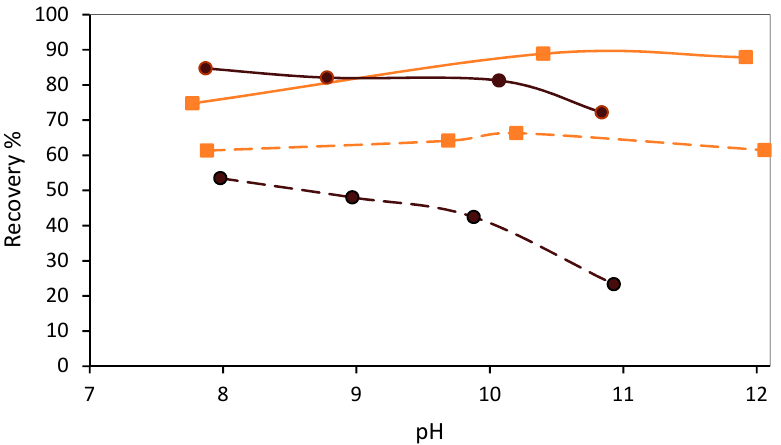
Figure 7. The influence of pH regulators ( ■ : NaOH, ● : Na 2 CO 3 ) on spodumene flotation recovery. The results for the activated and non-activated spodumene are represented by solid and dashed lines, respectively.